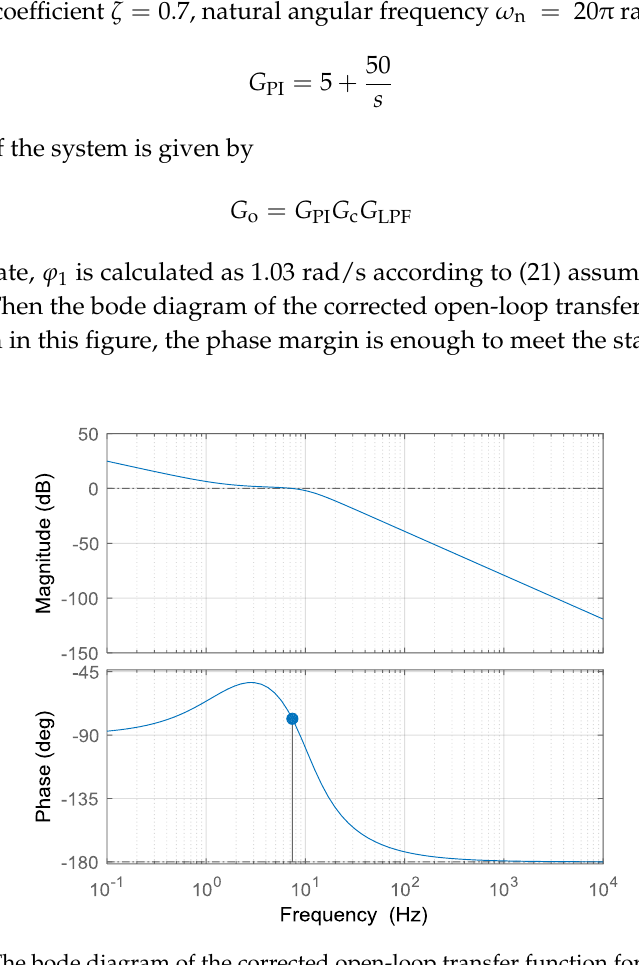
Figure 12. The bode diagram of the corrected open-loop transfer function for I avg control.